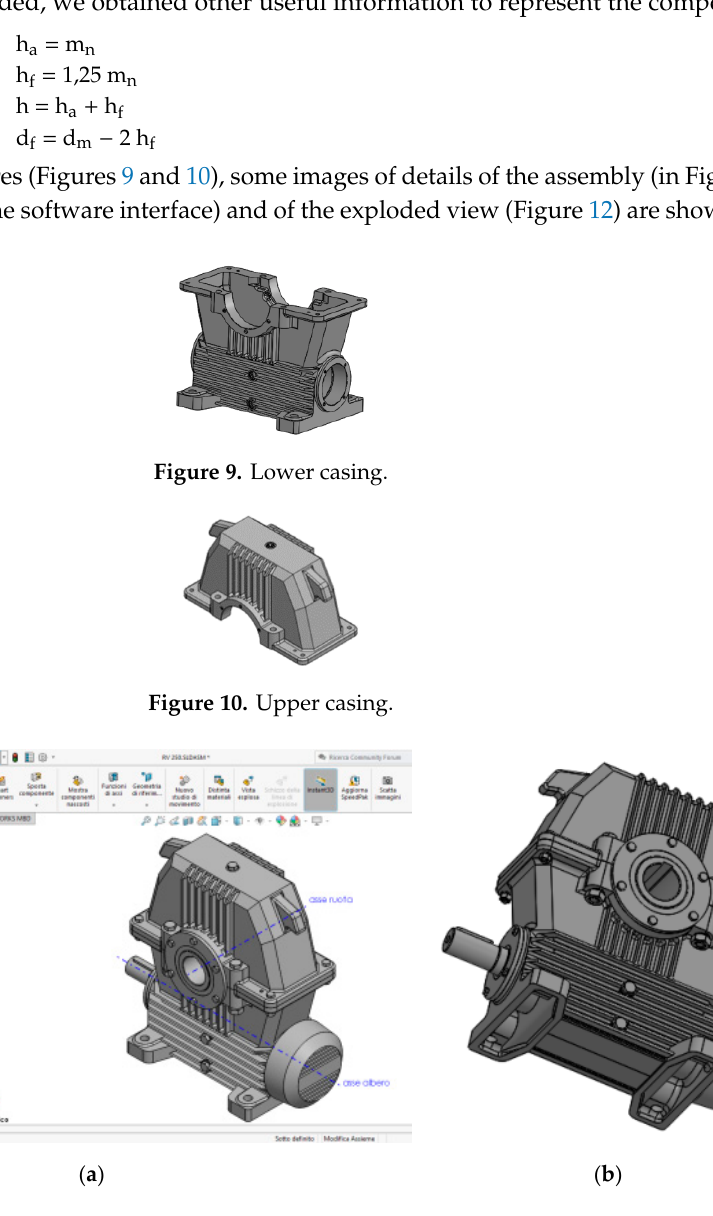
Figure 11. ( a ) Gearbox assembly;( b ) axonometry of gearbox assembly.